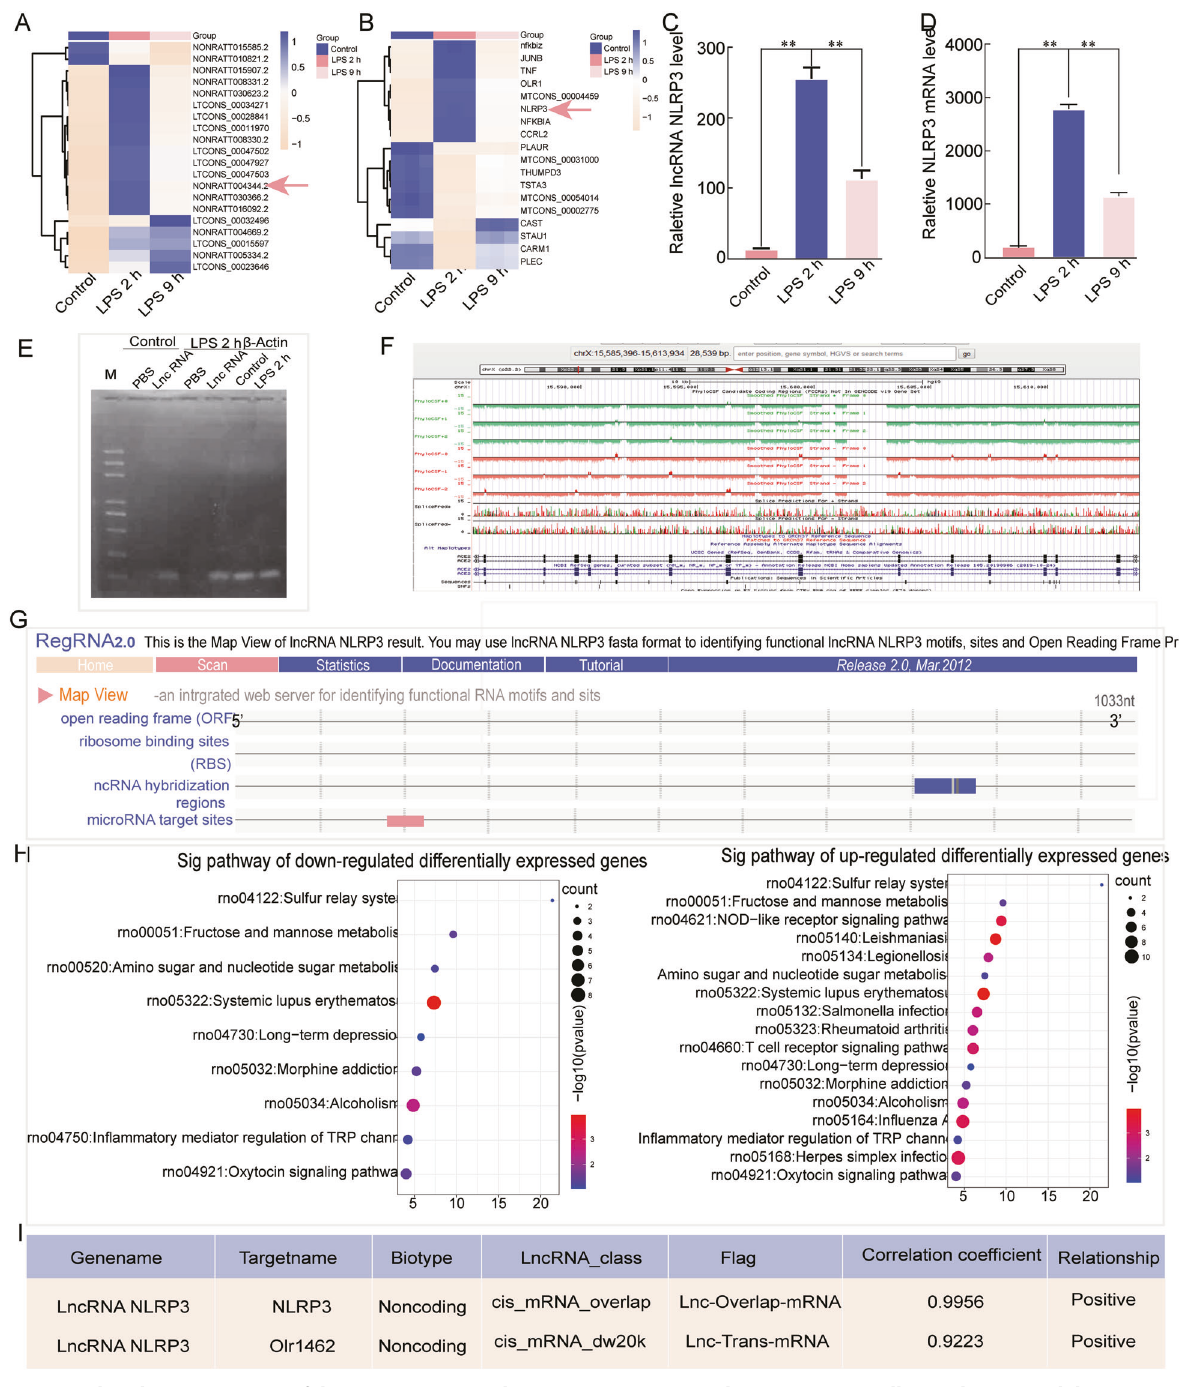
Fig. 1 Dysregulated transcription of lncRNA NLRP3 and NLRP3 in LPS-treated NR8383 AM cells as determined by RNA-seq and bioinformatics analysis. A The heat map lists the top 20 differentially expressed lncRNAs and mRNAs in NR8383 AM after treatment with PBS, LPS for 2 h, and LPS for 9 h. A , B RNA-seq analysis shows the quanti fi ed gene expression of lncRNA NLRP3 and NLRP3 in AM cells in the negative control, LPS 2 h, and LPS 9 h groups. C , D Agarose gel electrophoresis analysis shows the quanti fi ed expression of lncRNA NLRP3 and NLRP3 in NR8383 cells. β -Actin served as the control. E The conservation of lncRNA NLRP3 was predicted and analysed by the UCSC Genome Browser. F The lncRNA NLRP3 potential protein-coding and binding sites were analysed with RNA 2.0 tools. G The results show that lncRNA NLRP3 has no protein-coding capability. H Gene Ontology and Kyoto Encyclopedia of Genes and Genomes pathway analysis were used to analyze differentially expressed genes. I The relationship between lncRNA NLRP3 and NLRP3, and the correlation coef fi cient is listed. * P < 0.05; ** P < 0.01; *** P < 0.001; NS, no statistically signi fi cant difference.